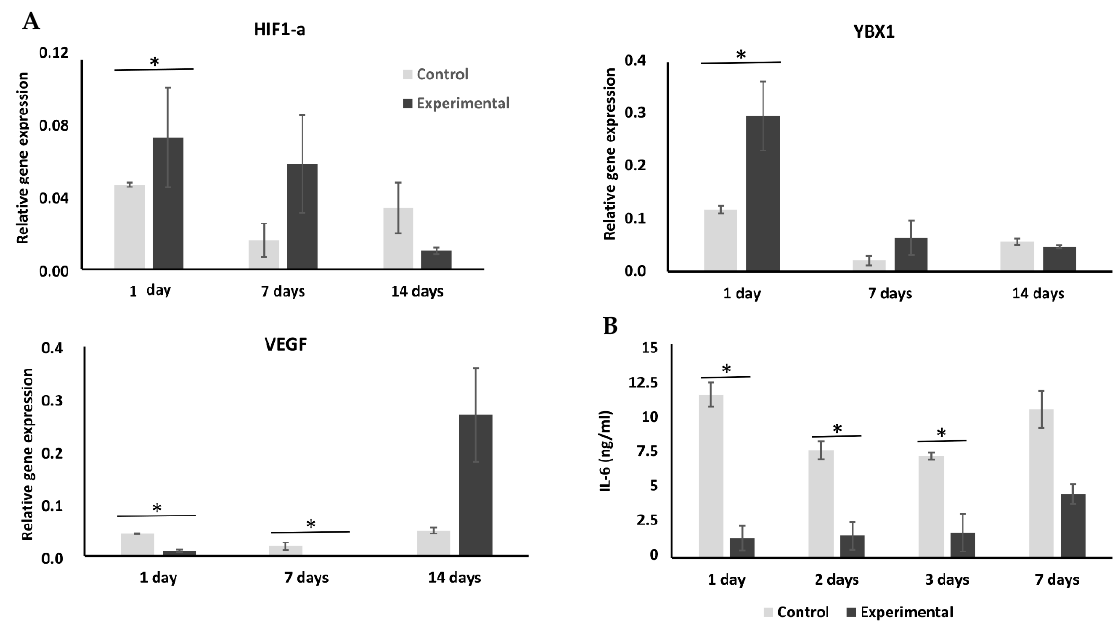
Figure 4. mRNA levels of gene expression of HIF1- α, YBX1 , and VEGF and IL-6 protein secretion at days 1, 7, and 14 of culture. ( A ) Expression of HIF1α, YBX1 , and VEGF genes was evaluated in experimental and control group hMSCs at days 1, 7, and 14 of culture in osteogenic-supplemented medium. ( B ) Concentration of IL-6 was measured in medium supernatants of both groups at days 1, 2, 3, and 7 of culture. (* p < 0.05).